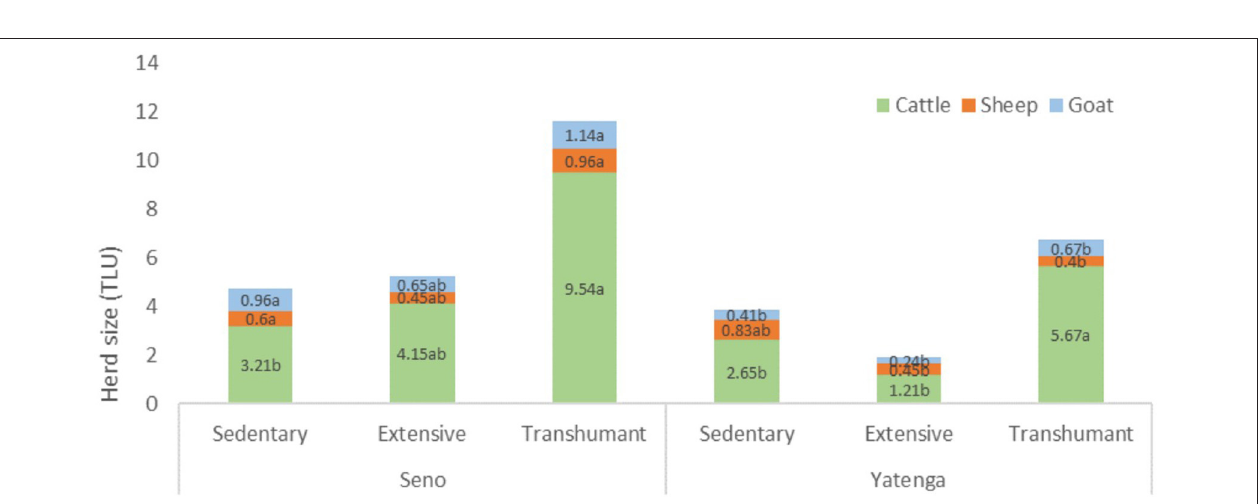
FIGURE 3 | Livestock assets across different management system in both